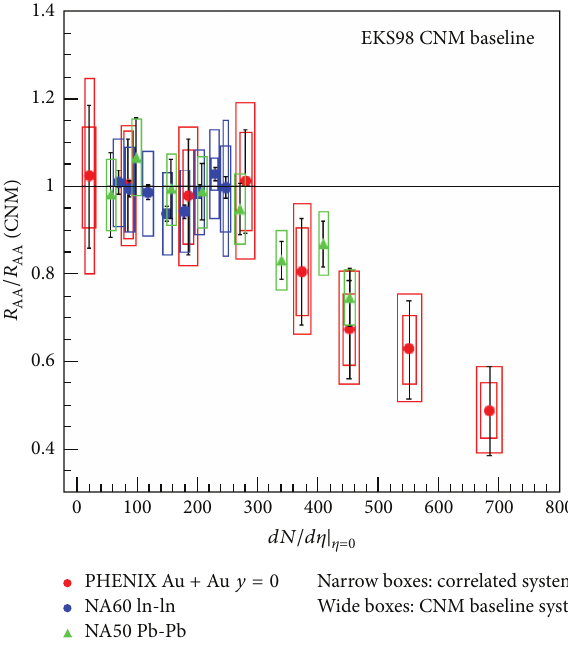
Narrow boxes: correlated system Wide boxes: CNM baseline system Figure 1: Comparison of the 𝑅 AA /𝑅 AA ( CNM ) ratio obtained at the SPS and PHENIX versus 𝑑𝑁/𝑑𝜂 at 𝜂 = 0